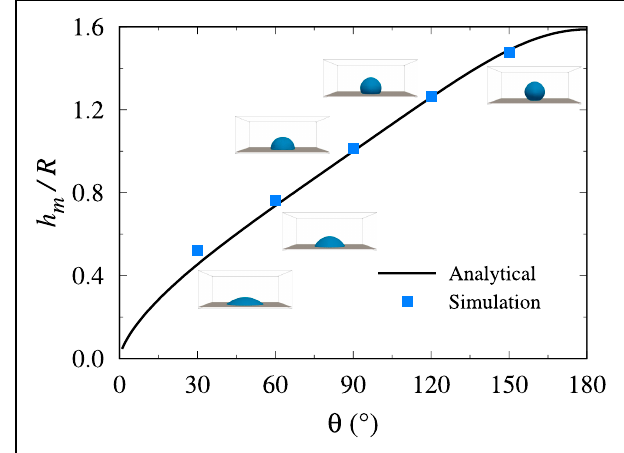
FIGURE 2 | Contact angle between the droplet and the plate.